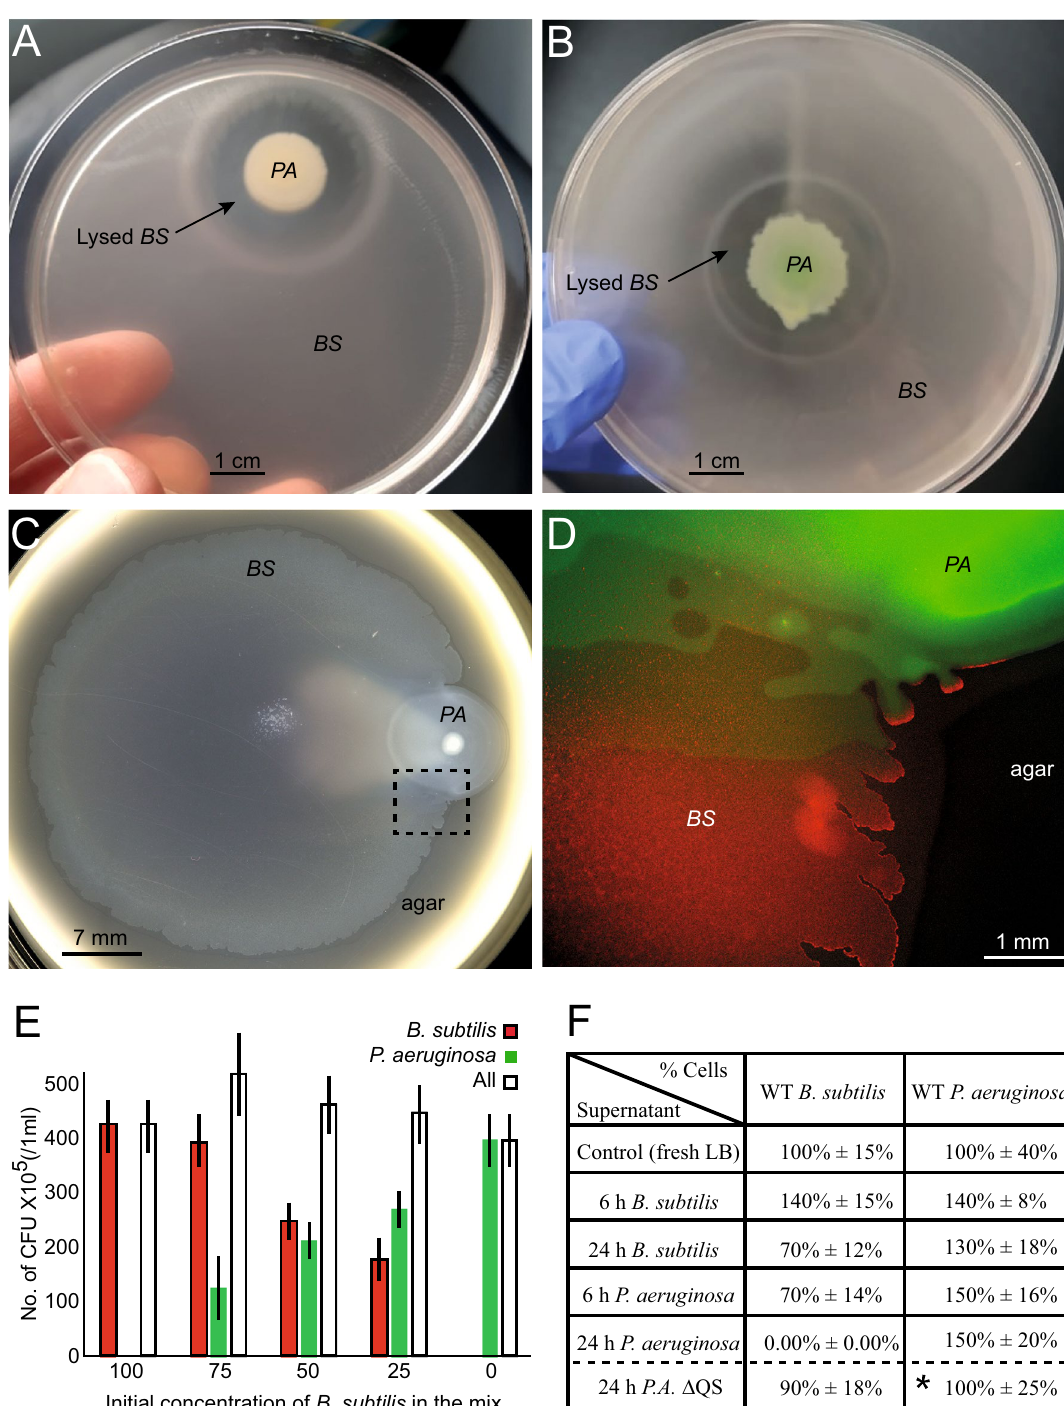
Figure 5. Biochemical interactions. ( A ) A 24-h old swarm plate with the two WT species initially inoculated at a large proximity (~ 5 cm). The B. subtilis spread throughout the entire plate, while the P. aeruginosa started lysing B. subtilis cells, forming an inhibition ring. ( B ) Same as A but for a single mixed colony. ( C ) Early stages of two WT colonies initially stated at a large proximity. No chemotaxis, attraction or repulsion was evidenced. ( D ) A fluorescence image at a larger magnification of the framed region in C, showing a mixed boundary. ( E ) Growth of the two WT species in a mixed broth for a variety of initial ratios between them. The Y-axis shows the number of cells after 6 h. Error bars represent the statistical error from 5 independent experiments. ( F ) Growth of each of the species in different media and for two different durations. The 100% for each of the species is considered as the growth in fresh LB. The last line marked with * shows results for a mix of WT B. subtilis and quorum-sensing deficient mutant of P. aeruginosa (strain 104). While B. subtilis grew in this mix, they did not grow when mixed with the WT P. aeruginosa (data above the dashed line in the